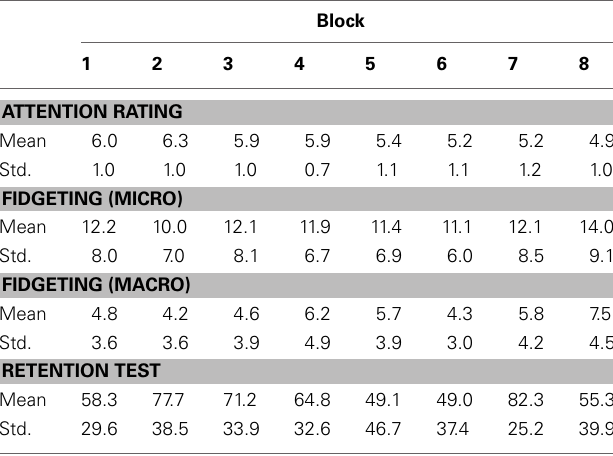
Table 1 | Subject means and standard deviations (std.) as a function of block for attention ratings, fidgeting (micro and macro), and performance on the retention